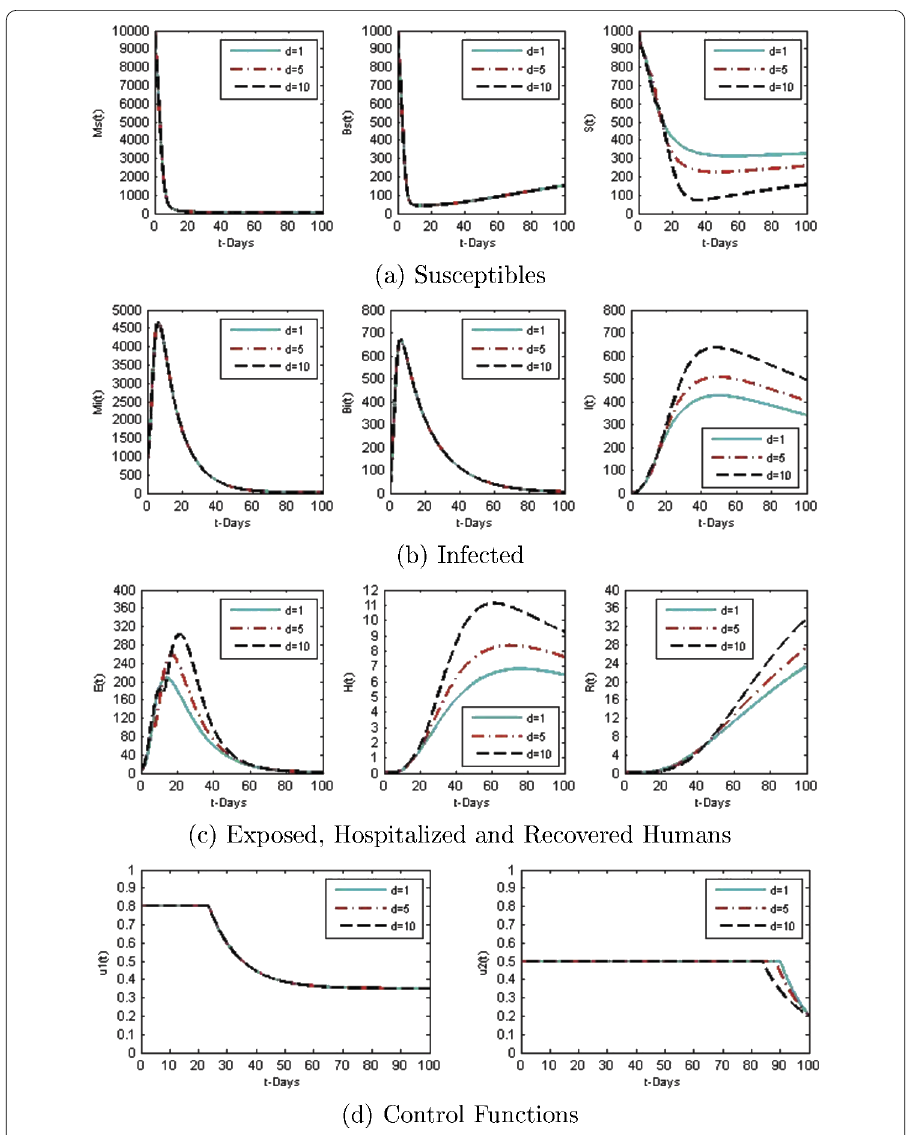
Figure 9 The approximate solutions of the fractional delay optimal control problem by using NSFDM. When α = 0.98 and different d , and (cid:7) t = 0.1